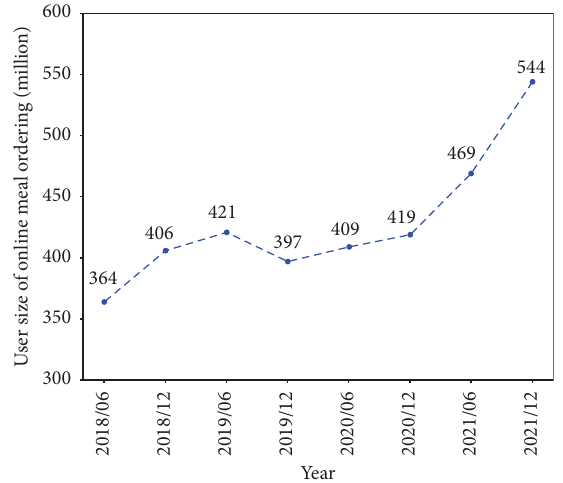
Figure 2: Online takeaway demand in China from June 2018 to December